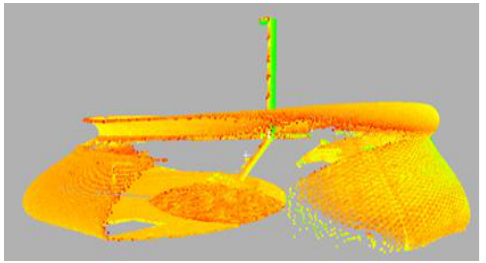
Figure 8. 3 D laser scan before refraction correction for Trial 1 [35,36] (used with permission).